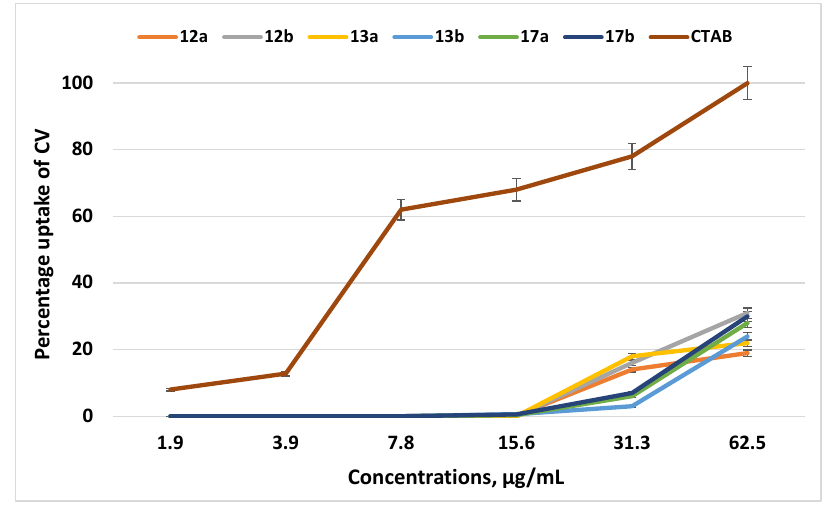
Figure 4. The percentage of crystal violet in S. aureus 209 P supernatant after 30 min incubation with various concentrations (μg/mL) of the test compounds and CTAB. The optical density of the sample at a wavelength of 540 nm with the dye in the absence of cells was taken as 100%.